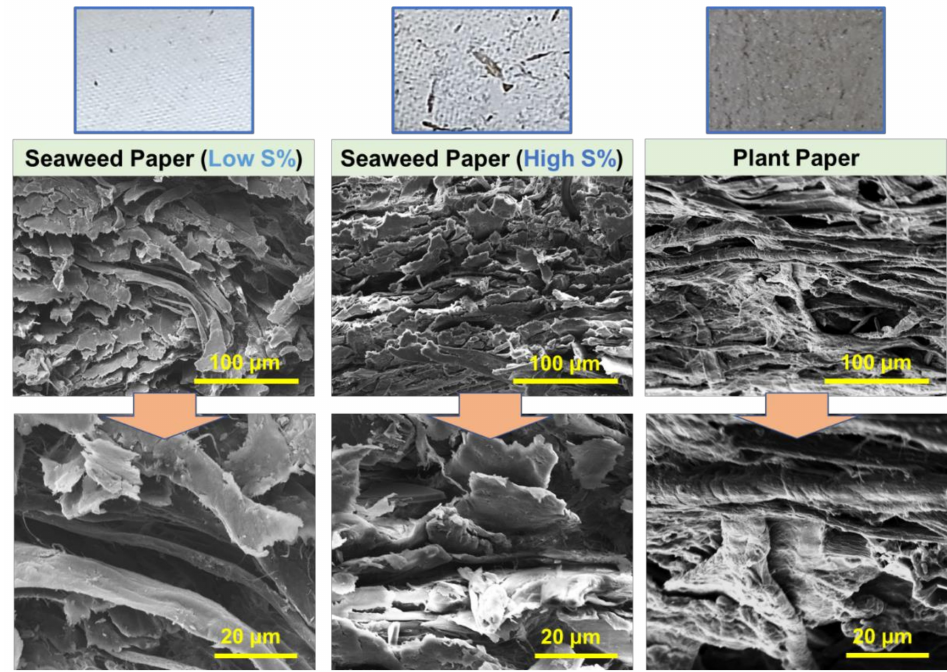
Figure 3. Photographs and SEM images of seaweed papers with different seaweed pulp contents (Low and High S%) and plant